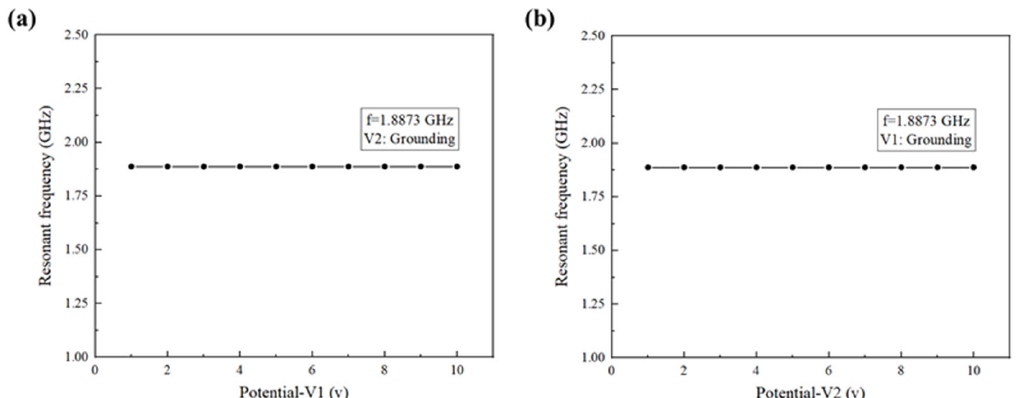
Figure 4. Noise immunity analysis of the SAWS. ( a ) The relation curve between the input voltage of electrode 1 and the resonant frequency of SAW; ( b ) the relation curve between the input voltage of electrode 2 and the resonant frequency of SAW.